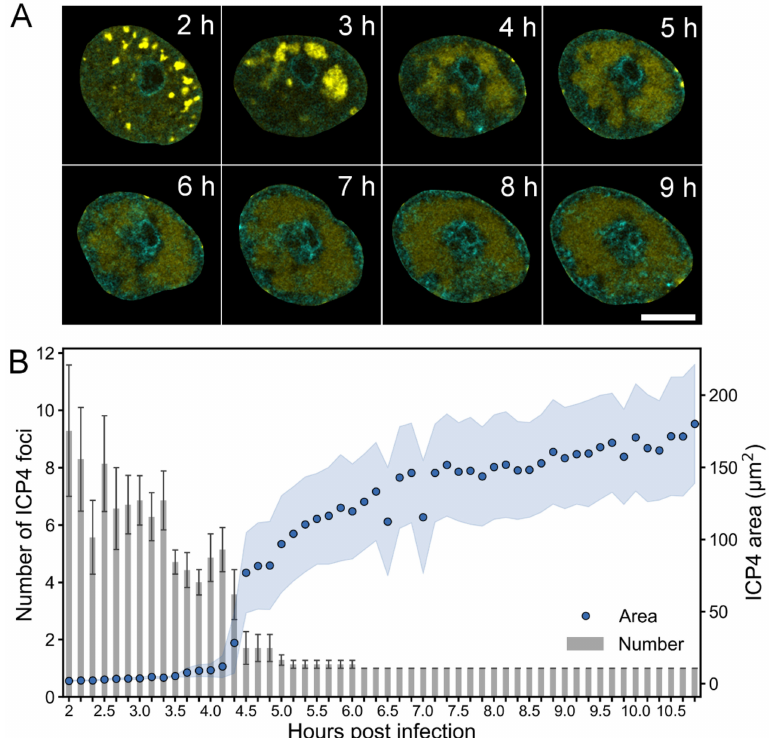
Figure 1. Formation of HSV-1 replication compartment. ( A ) Confocal microscopy images showing the distribution of EYFP-ICP4 (yellow) at 2–9 hpi in Vero cells with DNA visualized using Hoechst 33342 dye (cyan). Scale bar is 5 µ m. See also Movie S1 and Figure S1. ( B ) A quantitative analysis of the number and area of EYFP-ICP4 foci during infection ( n = 7). The mean values of the number of EYFP-ICP4 foci ± the standard error of the mean (SEM) are shown. The blue shading around the area data points represent the mean ±